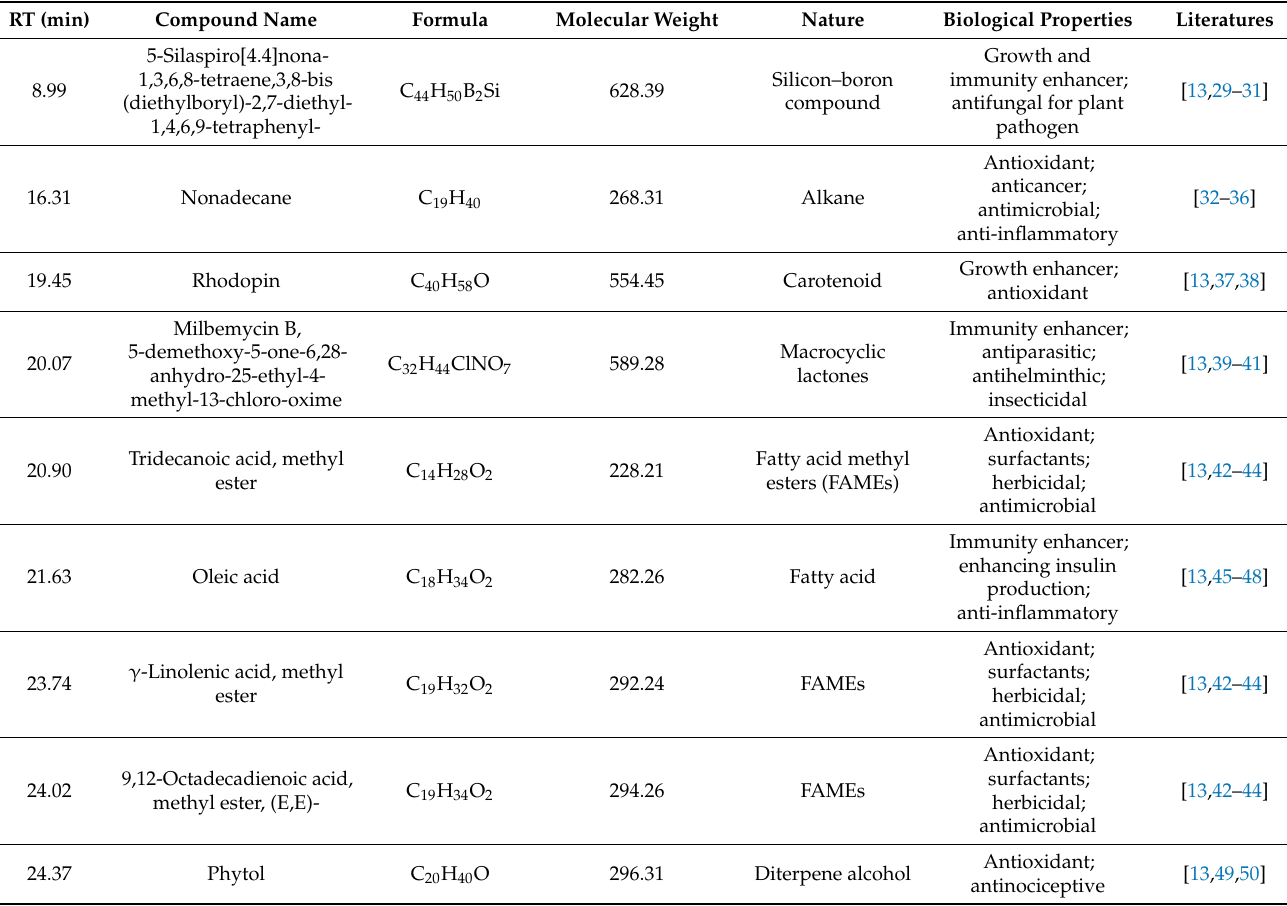
Table 2. Phytochemical compounds of TAM and related biological activities according to the